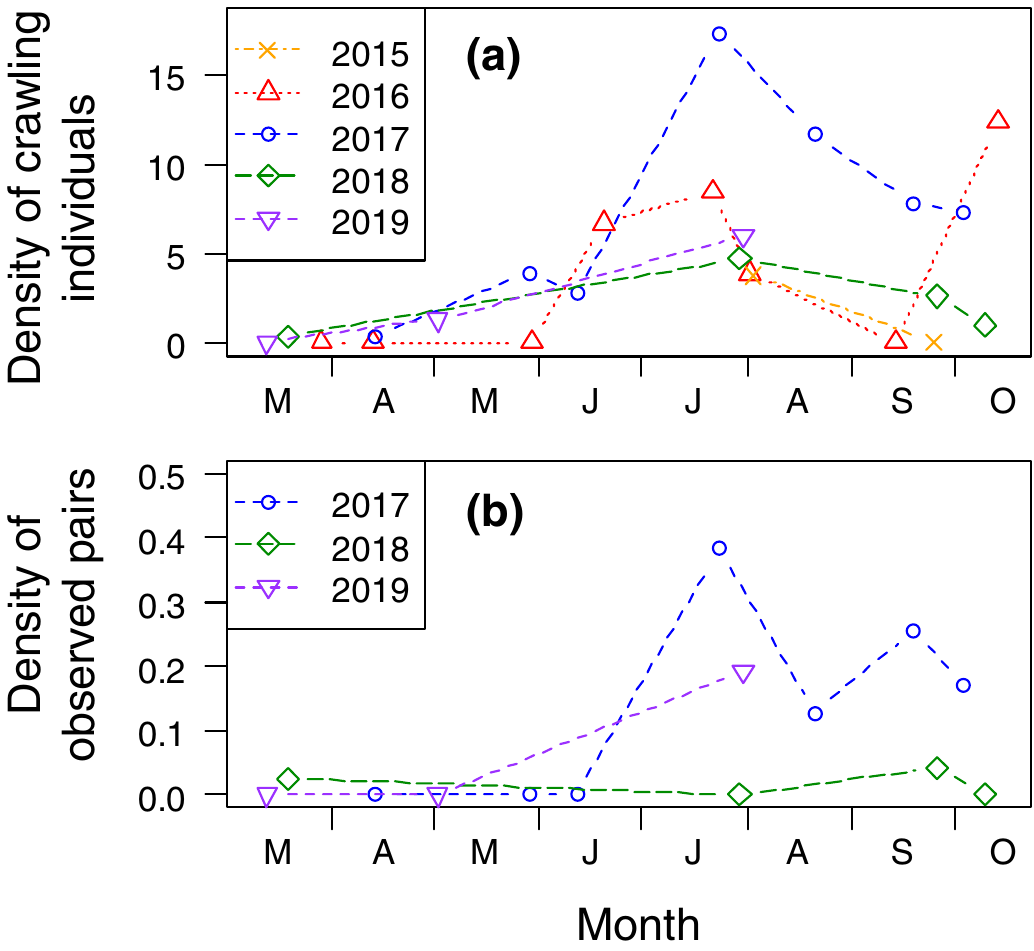
Figure 2. Seasonal changes in densities (the number per 100 m 2 ) of ( a ) crawling Laguncula pulchella individuals and ( b ) mounting pairs found in the